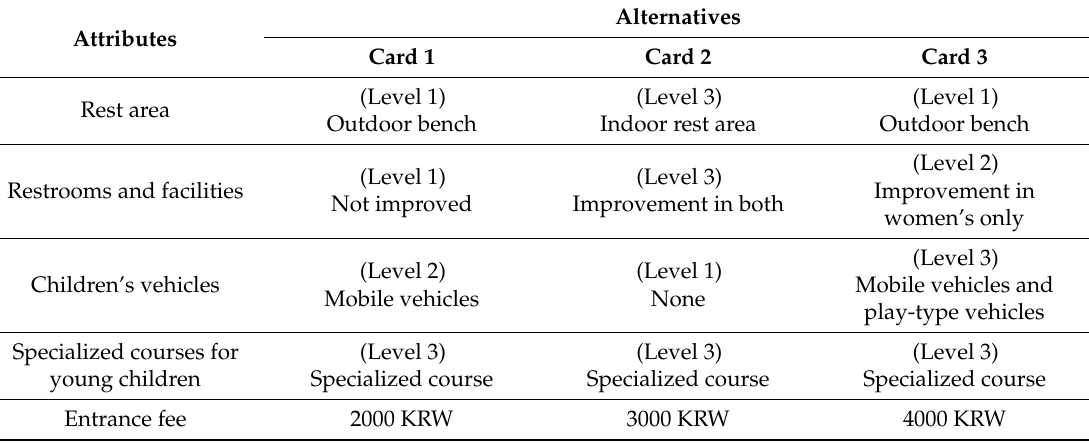
Table 2. Examples of cards with di ff erent levels of attributes in the choice